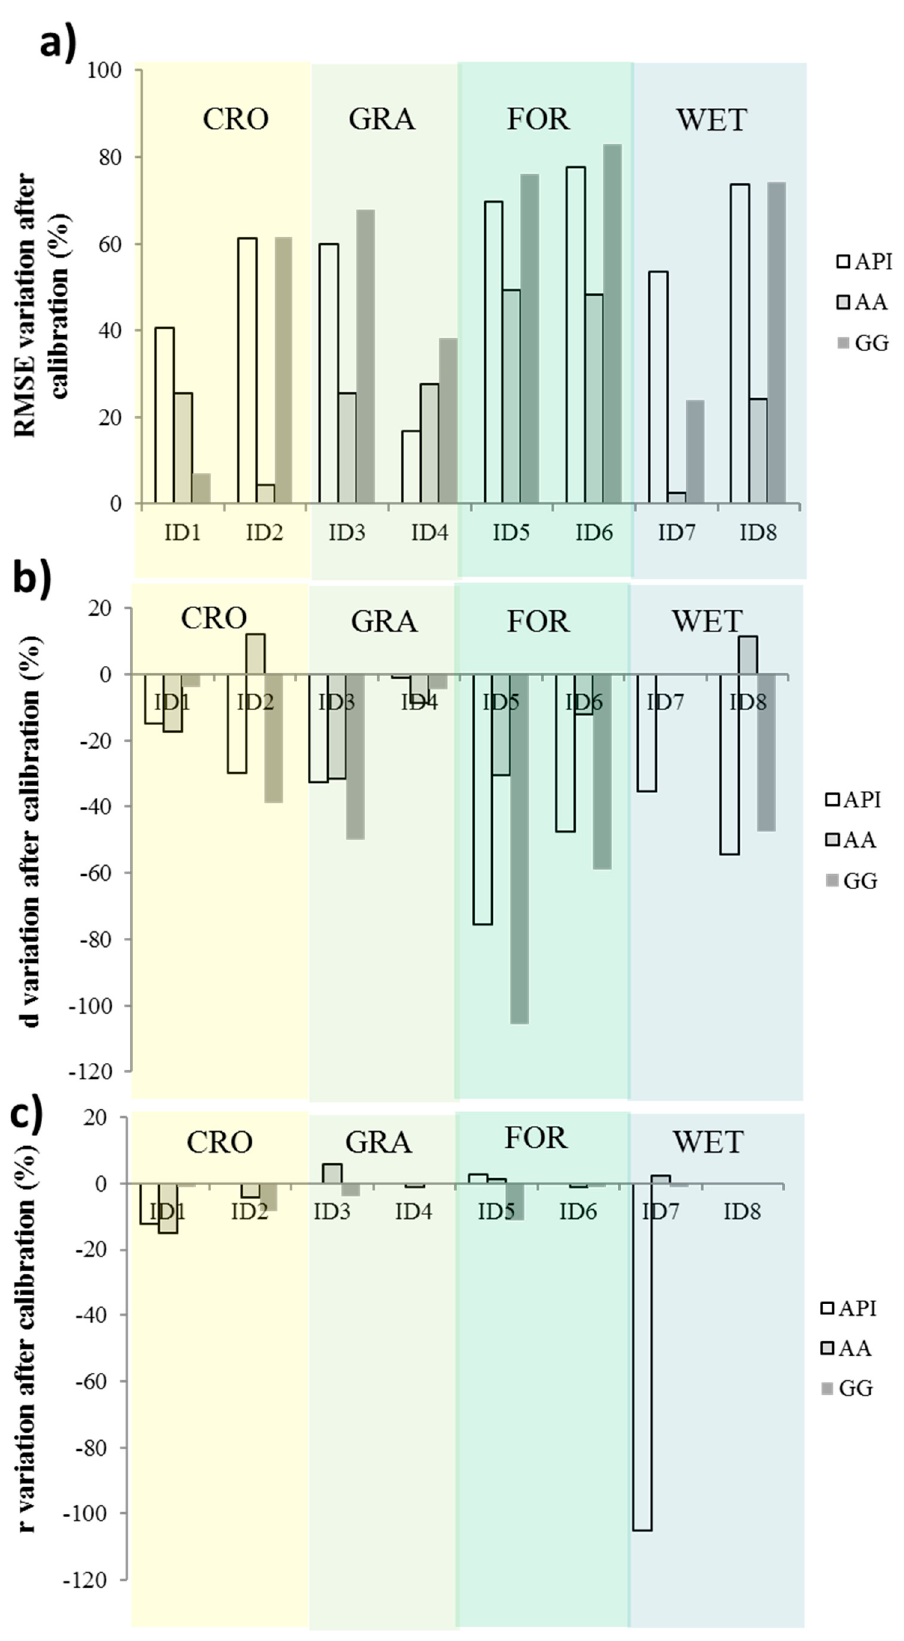
Figure 7 . Relative difference in ( a) RMSE, ( b ) d, and ( c ) r before and after the calibration process. Figure 7. Relative difference in ( a ) RMSE, ( b ) d, and ( c ) r before and after the calibration